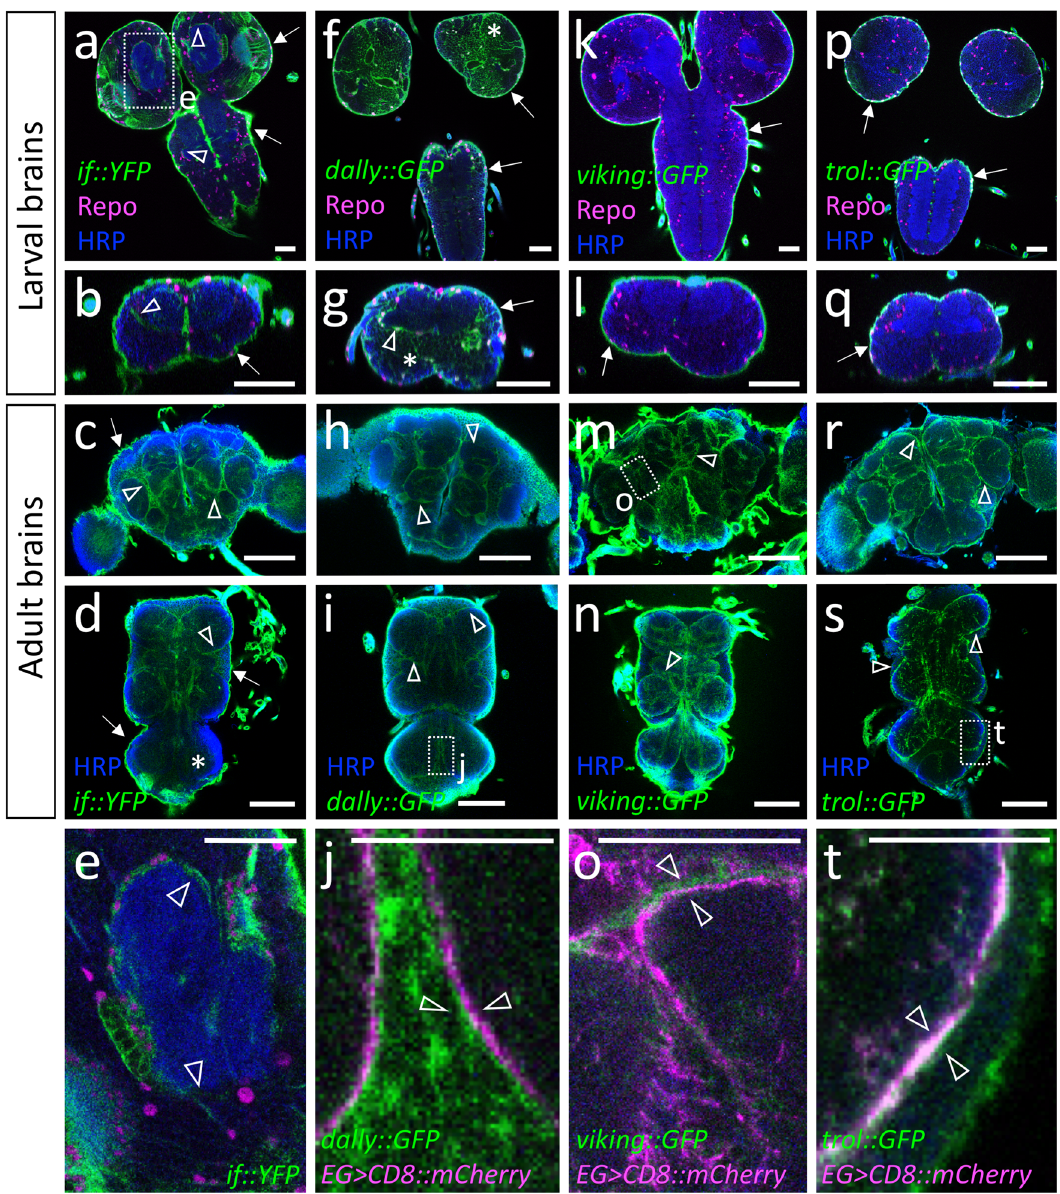
Fig. 7 The ensheathing glial cells are fl anked by extracellular matrix. Representative images are shown. Expression of Integrin α and different extracellular matrix components as detected by using gene trap insertion lines. a – e Endogenously YFP-tagged Integrin α encoded by the in fl ated gene. f – j Endogenously GFP-tagged heparan sulfate proteoglycan Dally protein encoded by dally::GFP . k – o Endogenously tagged Collagen IV protein encoded by viking::GFP . p – t Endogenously tagged Perlecan encoded by trol::GFP . The different developmental stages are indicated. a , i , m , s The boxed areas are shown in the bottom row. Glial cells are in magenta (anti-Repo staining), neuronal membranes are in blue (anti-HRP staining) and the GFP-tagged proteins are in green (anti-GFP staining). a , b , e During late larval stages, prominent In fl ated expression is seen at the blood – brain barrier (arrows) and weak expression is seen around the neuropil at the position of the ensheathing glia (arrowhead). c , d In adults, Integrin α is still found at the blood – brain barrier (arrows) and becomes more prominent around the neuropil (arrowheads). Note that strongest In fl ated expression is detected in larval brains. No In fl ated expression can be detected in the abdominal neuromeres (asterisk). f , g During the larval stage Dally is expressed at the blood – brain barrier (arrows) and in the CNS cortex (asterisks). A slightly stronger localization of Dally can be detected at the position of basal ensheathing glia processes (arrowhead). h – j In adults, Dally is enriched at the position of the ensheathing glia (arrowheads). k , l In the larval CNS Collagen IV is found at blood – brain barrier (arrows) but not within the nervous system. m – o Collagen IV is detected at the neuropil-cortex interface in adult stages (arrowheads in m , n , boxed area is shown in ( o )). p , q Trol is detected at the larval blood – brain barrier (arrows) but not around the neuropil. r – t In adults, prominent Trol localization is seen at the position of the ensheathing glia (arrowheads). The boxed area in ( s ) is shown at higher magni fi cation in ( t ). Scale bars are: larval CNS 50 µ m, adult CNS 100 µ m except for e : 25 µ m; j , o , t : 50 µ